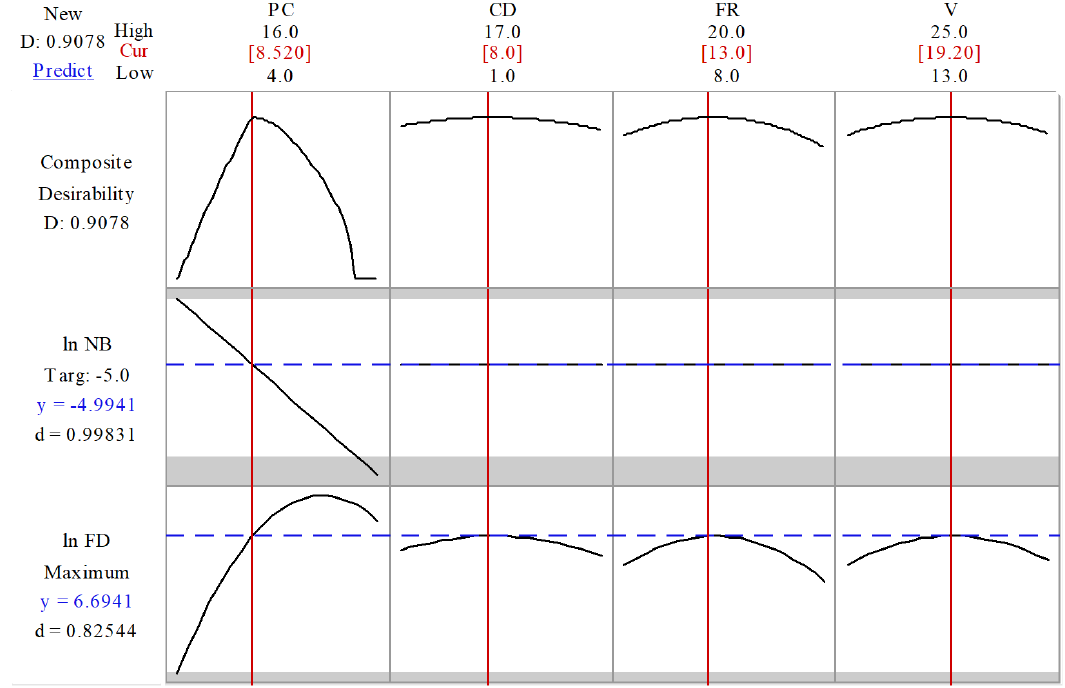
Figure 4. Optimization plot detecting the optimum factors settings to achieve beaded fibers with high FD and intermediately high NB, where the vertical redlines represent the factor setting chosen (its value is shown at the top of each column in red), whereas the horizontal blue lines represent the predicted response values (its value is shown on the left of each column in blue). Composite (D) and individual desirability (d) scores are displayed on the left.